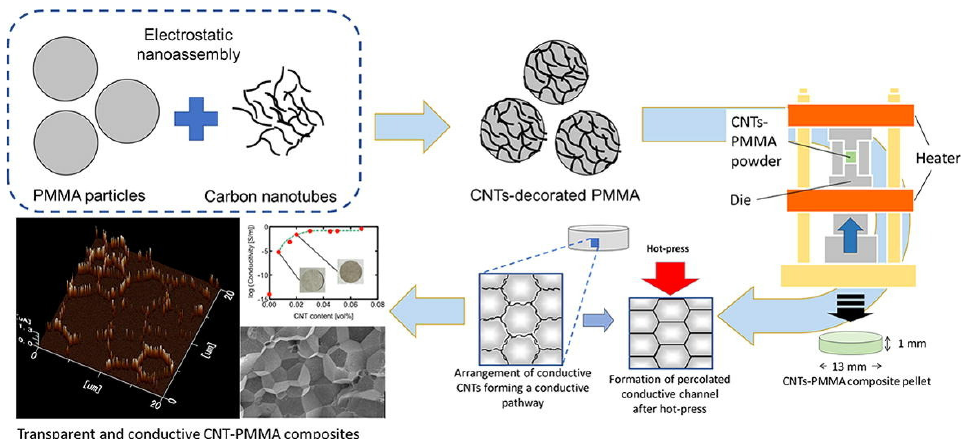
Figure 20. Electrostatically nano-assembled carbon-nanotubes-decorated poly(methyl methacrylate) (PMMA) particles for fabrication of transparent conductive polymer composites. Reprinted/adapted with permission from Ref. [71]. 2020, Elsevier.